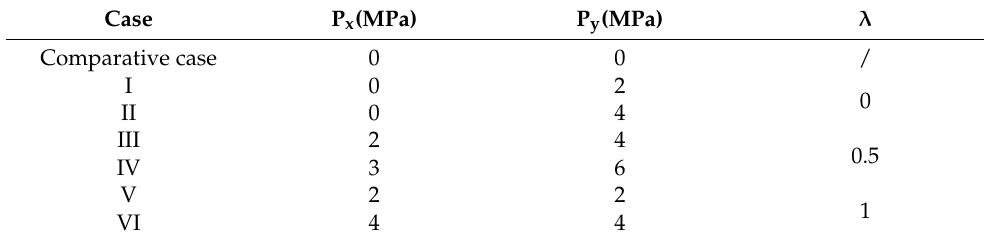
Table 3. Six analysis cases under different in-situ stresses.